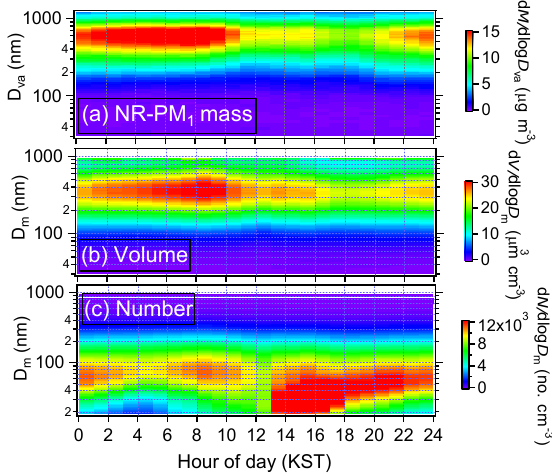
Figure 5. (a) Diurnal variations of the size distribution of NR- PM 1 mass from the AMS (in vacuum aerodynamic diameter, D va ); (b) volume from the SMPS (in mobility diameter, D m ) and (c) num- ber concentrations from the